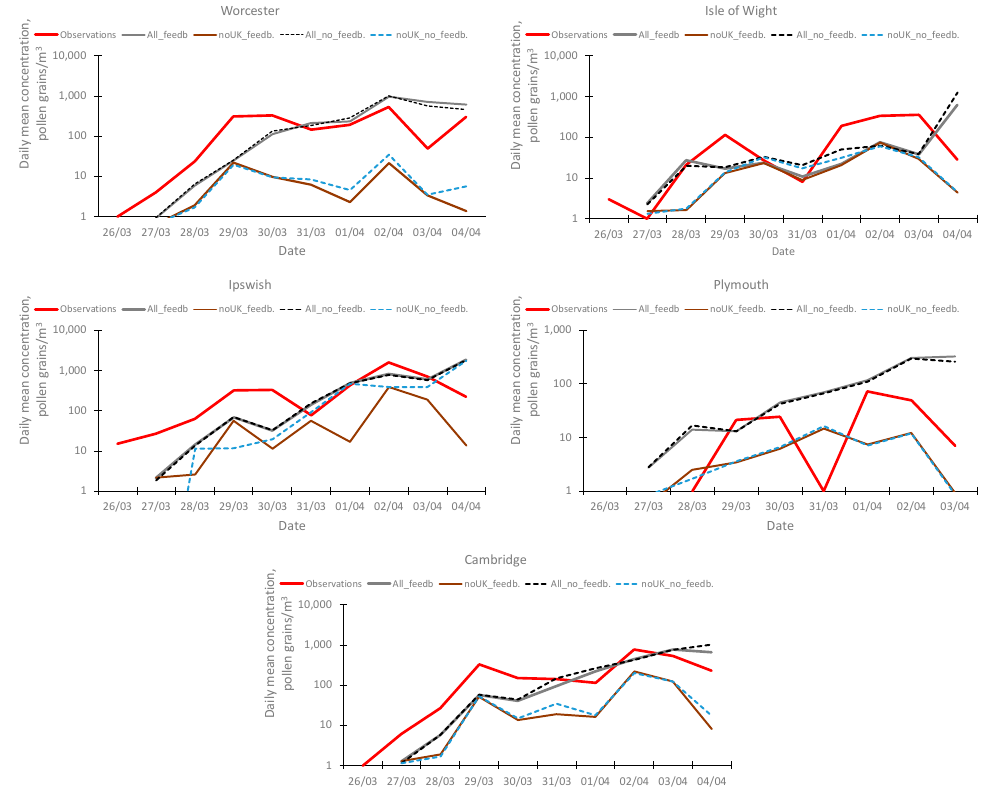
Figure 3. Calculated birch pollen concentrations at the 6 sites, with and without radiation feedback, and splitting using two scenarios: without the UK pollen sources and two scenarios with all pollen sources included. The calculated concentrations are plotted versus the observations (red line). Note the y-axis is logarithmic in order to highlight differences at low concentrations.